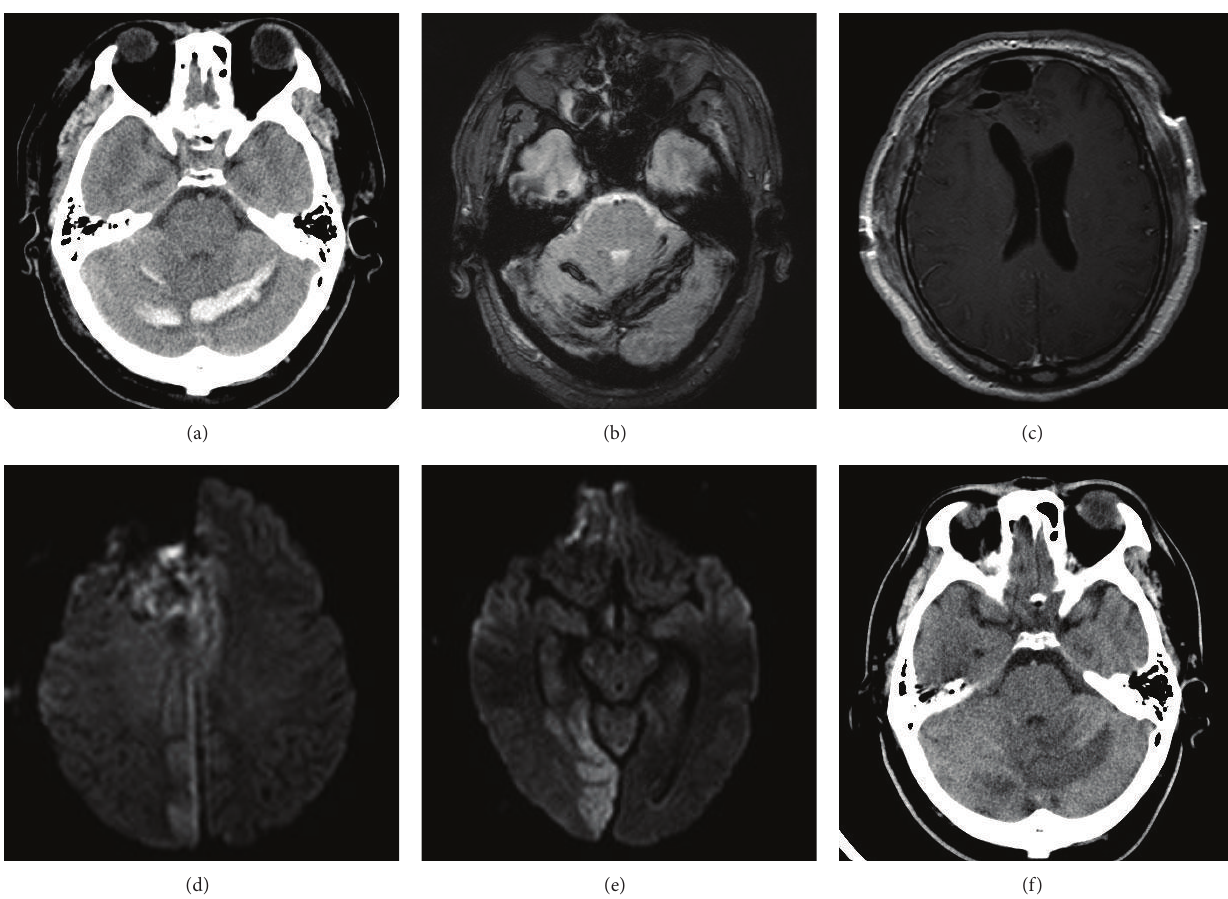
Figure 2: ((a), (b)) Computed tomography (a) and axial T2 ∗ -weighted imaging (WI) magnetic resonance (b) images on postoperative day 1 showing a bilateral cerebellar hemorrhage along with the cerebellar sulci facing the tentorium. (c) Axial T1-WI with gadolinium showing no evidence of residual tumor in the surgical site. ((d), (e)) Axial diffusion-weighted imaging (DWI) revealing bilateral anterior cerebral artery infarction due to subfalcial herniation (d) and right posterior cerebral artery infarction due to transtentorial herniation (e) that reflected the preoperative intracranial hypertension. (f) Follow-up computed tomography image showing no further progression of